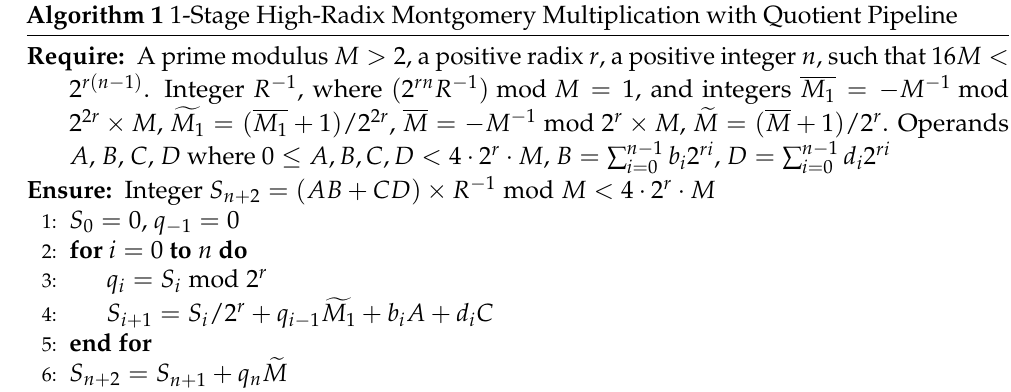
Algorithm 1 1-Stage High-Radix Montgomery Multiplication with Quotient